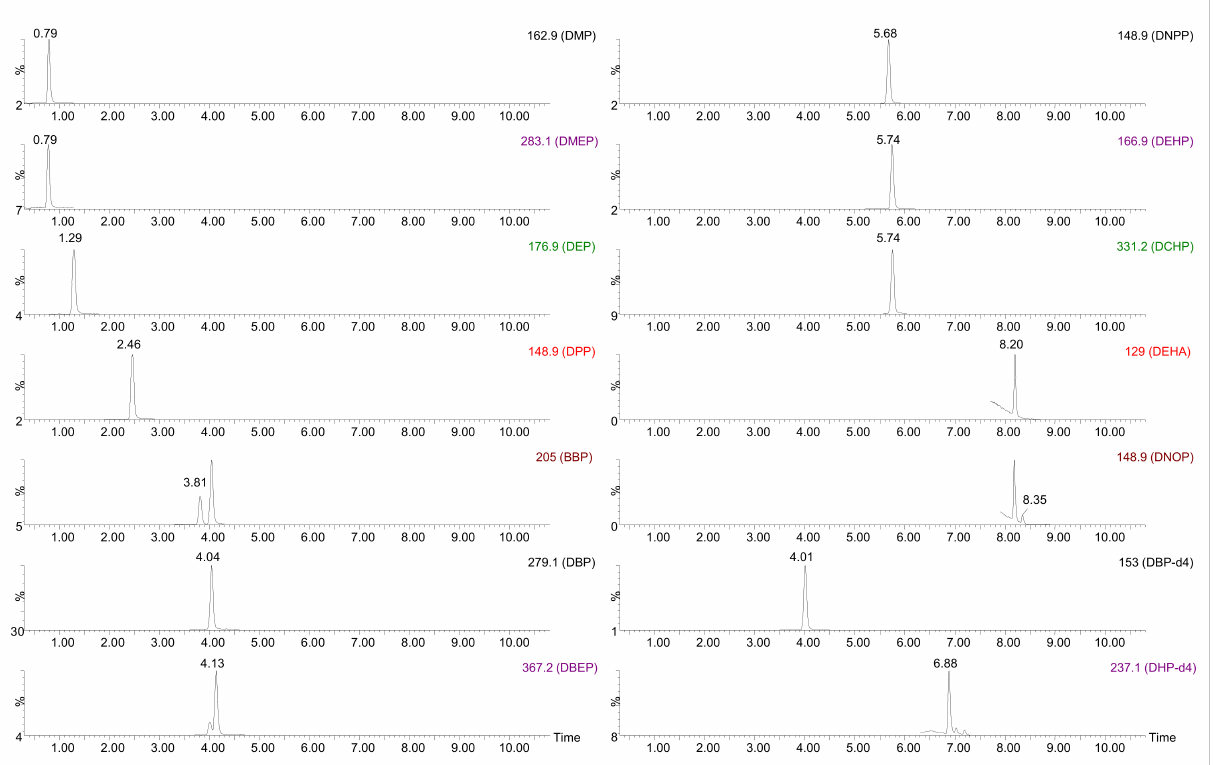
Figure 1. UHPLC-MS chromatogram for a mixture of standards at 150 µ g/L. Aqueous mobile phase: 0.1% v / v formic acid in Milli-Q water. Organic mobile phase: 0.1% v / v formic acid in acetonitrile. Flow: 0.3 mL/min. MS operated in SIM